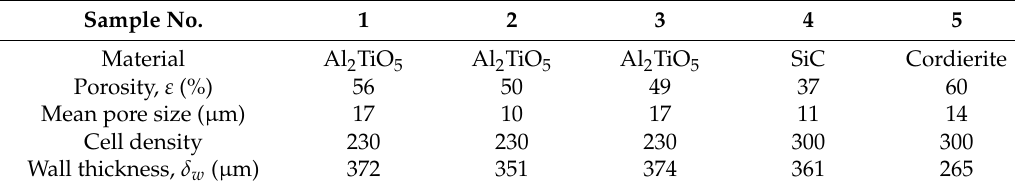
Table 1. Filter properties of five samples used in the